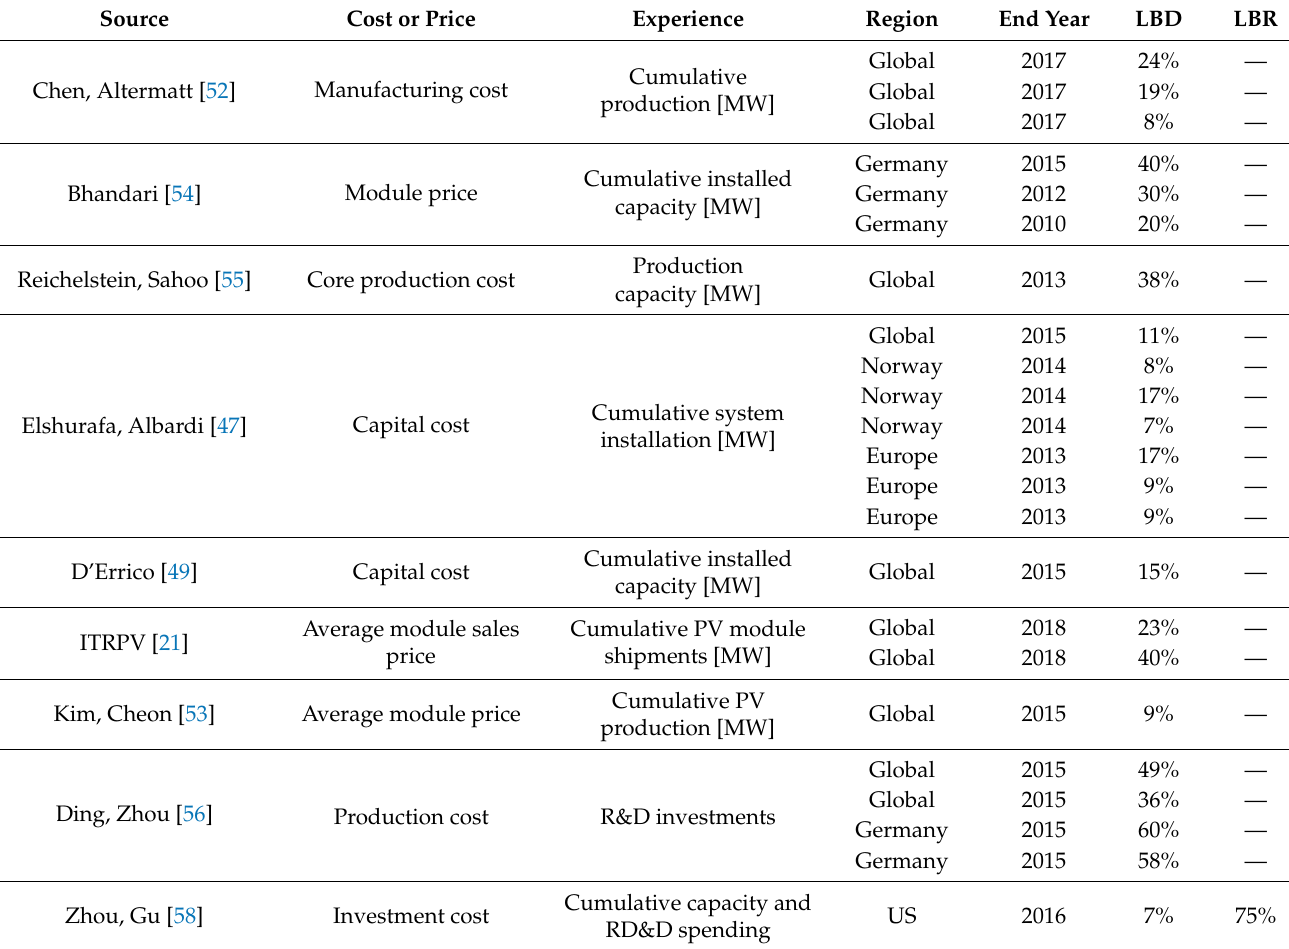
Table A1. Recent studies that report LRs for solar power and specifically photovoltaics.